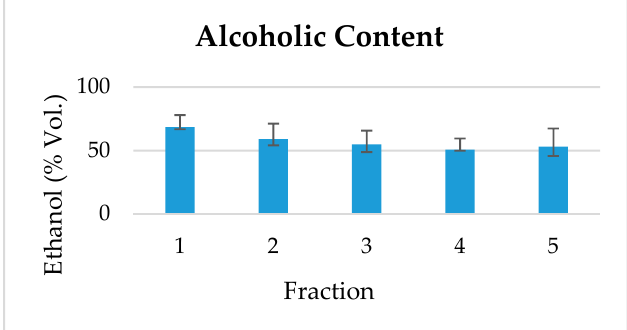
Figure 3. Alcoholic degree of the distilled fractions obtained in the continuous distillation.